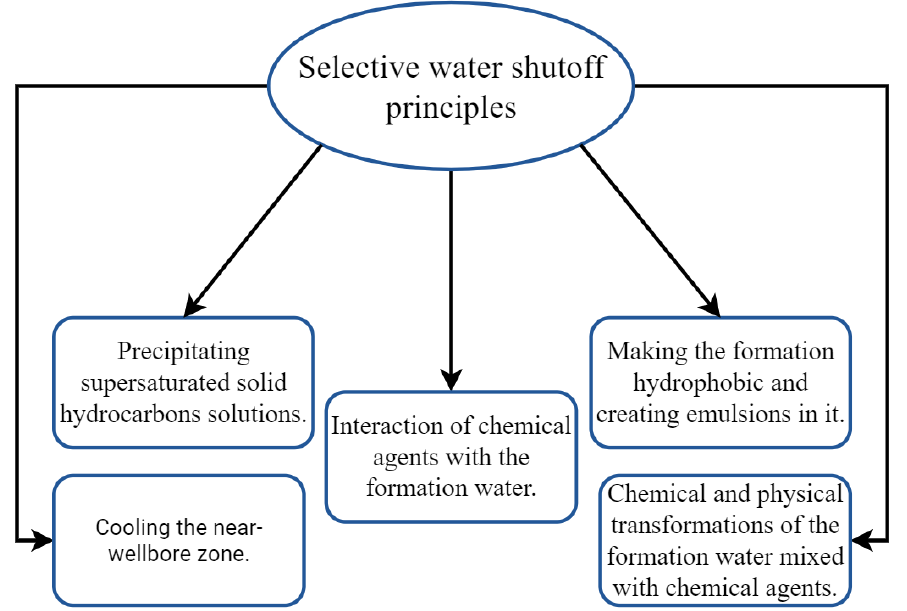
Figure 1. Major groups of selective water shutoff principles.